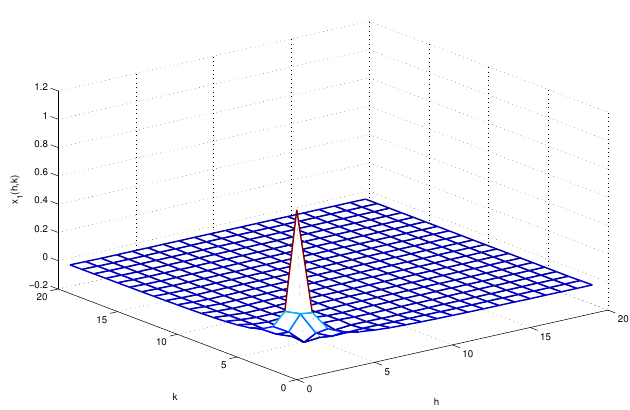
Figure 1. State component response: x 1 .